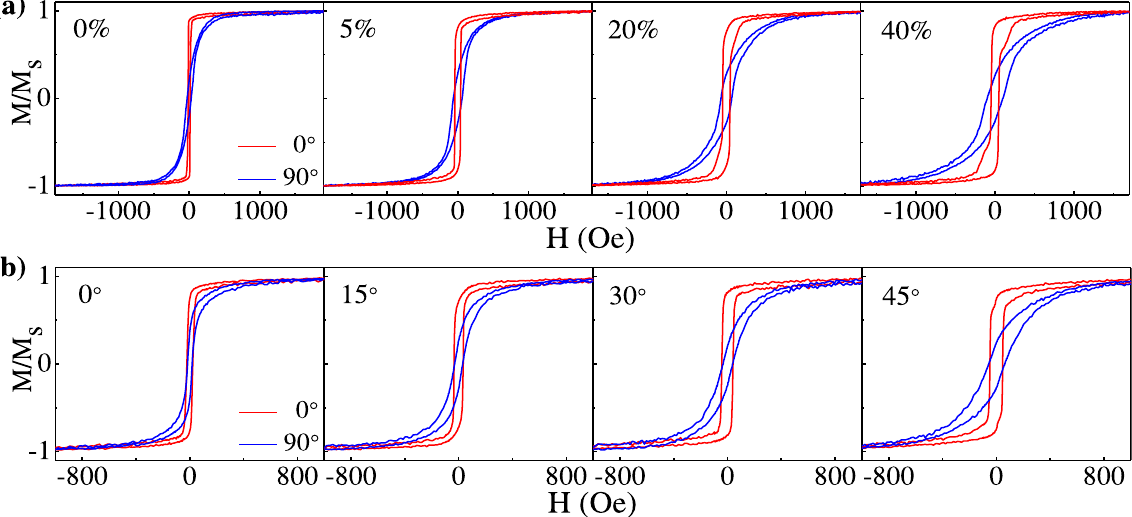
2   2 ( ) 3 − ν E 1 π ε t t 1 s f   f f pre , where ε = . is a certain threshold λ = ⋅ = ⋅ − A and 1 0 52 c   2 ε ε ξ ε + + + + ( ) − ν E (1 ) ε ξ c c 1 3 1 3 1 (1 ) 1 (1 ) pre f s pre 5 , t ƒ is the total strain for buckling and has to be exceeded for obtaining a wrinkle pattern, ξ ε ε = + (1 ) pre pre 32 thickness of metal layers. E s and ν s are the Young’s modulus and Poisson’s ratio for PDMS membranes and the same as the E ƒ , ν ƒ for Ta films, respectively. Based on the previously reported elastic parameters for Ta bulks ( E ƒ = 100 GPa, ν ƒ = 0.3) and PDMS membranes ( E s = 1 MPa, ν s = 0.5), we may predict the wavelength and the amplitude of the wrinkled Ta/PDMS surface. For example, a wavelength of 779 nm and an amplitude of 121 nm are estimated for the topography of Ta(5 nm)/PDMS grown with ε pre = 20%, which agree well with the experimen- tally obtained results 21 . Since the elastic parameters almost cannot be changed, in order to obtain a wrinkled surface with a desired wavelength and amplitude, both the PDMS pre-strain and the thickness of metal layer need to be well controlled. After obliquely depositing a 150 nm FeCoTa layer onto the wrinkled Ta/PDMS surface, the wavelength approximately keeps unchanged, but the amplitude is increased. Figure 1(d) typically indicates the surface topog- raphy for a 150 nm FeCoTa film obliquely deposited at ϕ = 45° on a wrinkled Ta/PDMS surface obtained by using ε pre = 20%. As shown in Fig. 1(e), the corresponding cross-sectional view is no longer fluctuated according to a sine function. The peaks of wrinkles are shifted by 127 nm toward the incident atomic flux. The magnetic layer on the wrinkle side faced to the oblique sputtering become much thicker than that on the opposite side due to the enhanced shadowing effect by the wrinkled morphology. Although we use a fixed incidence angle to obliquely deposit FeCoTa layer, the sinuously oscillated morphology of Ta/PDMS makes the atomic flux display- ing different incidence angles, which consequently gives rise to the inhomogeneous thickness and changes the sinuously wrinkled surface. For a fixed ε pre , the decrease of the oblique sputtering angle may reduce the shift of wrinkles. For fixing ϕ = 45° to grow FeCoTa but change the pre-strain of PDMS to obtain different wrinkled Ta/ PDMS surfaces, the wavelength of wrinkles determined by the Ta buffer layer decreases from 929 to 655 nm with increasing ε pre from 5% to 40%, but the corresponding amplitude increases from 151 to 289 nm and the shift of peak gradually decreases from 147 to 19 nm. Obviously, the increase of either the oblique deposition angle or the pre-strain applied on PDMS may enhance the shadowing effect, leading to an inhomogeneous thickness and a non-sinuously wrinkled topography. Figure 2(a) shows the hysteresis loops measured with an in-plane magnetic field applied parallel ( θ = 0°) and perpendicular ( θ = 90°) to the wrinkles for FeCoTa films grown with different ε pre and a fixed ϕ = 45°. All the wrinkled FeCoTa films display a uniaxial magnetic anisotropy with the easy axis along the wrinkles. When ε pre is varied from 0% to 40%, the coercivity measured along the easy axis increases from 15 to 49 Oe. By means of calculating the difference of the area enclosed between the hysteresis loops measured along the easy and hard axes 33 , the magnetic anisotropy is estimated to increase from 3.68 × 10 4 to 1.30 × 10 5 erg/cm 3 . Figure 2(b) shows the hysteresis loops for FeCoTa films grown with different ϕ and a fixed ε pre = 30%. With increasing ϕ from 0° to 45°, the coercivity measured along the easy axis correspondingly increases from 24 to 47 Oe and the uniaxial magnetic anisotropy increases from 2.16 × 10 4 to 1.21 × 10 5 erg/cm 3 . It is well known that the method of oblique deposition may result in a uniaxial magnetic anisotropy with an easy axis perpendicular to the incident atomic flux. The oblique deposition onto the sinuously wrinkled surface may enhance the effect of shadowing and sig- nificantly increase the uniaxial magnetic anisotropy of magnetic films. On the other hand, the wavy morphology of wrinkled magnetic films can produce an additional surface magnetic anisotropy. When a saturation magnetic